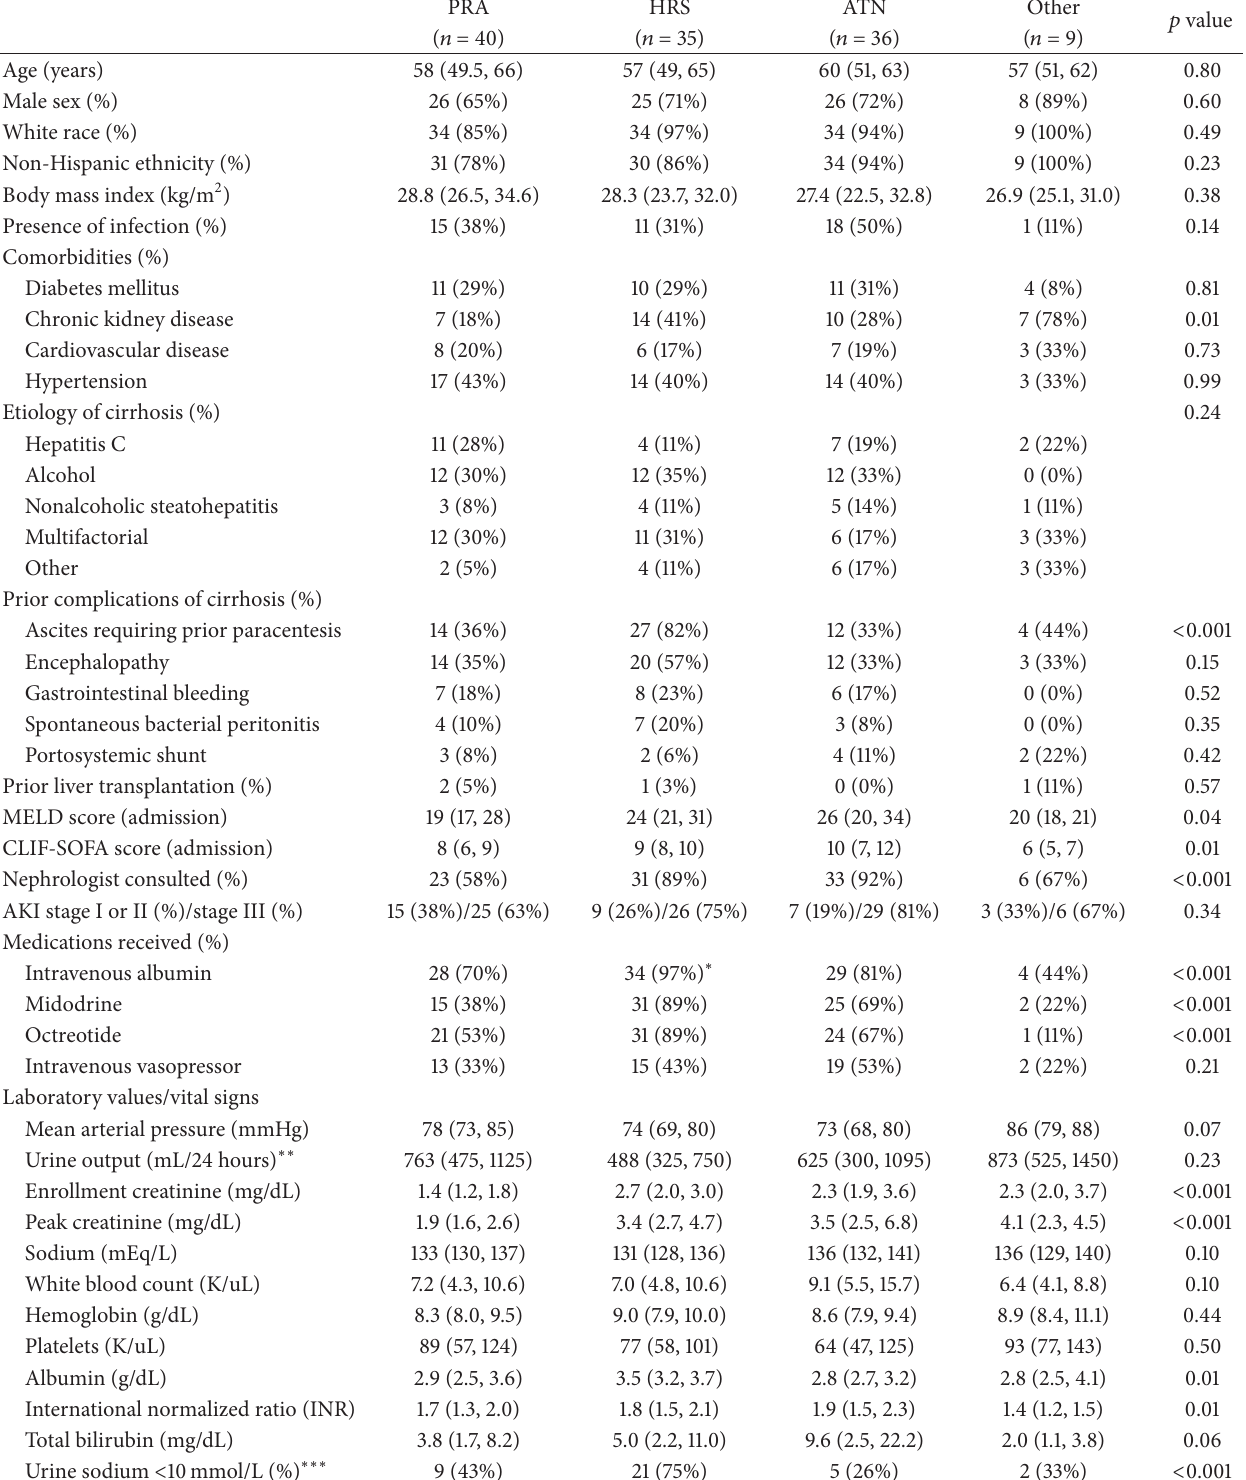
Table 1: Demographics and clinical